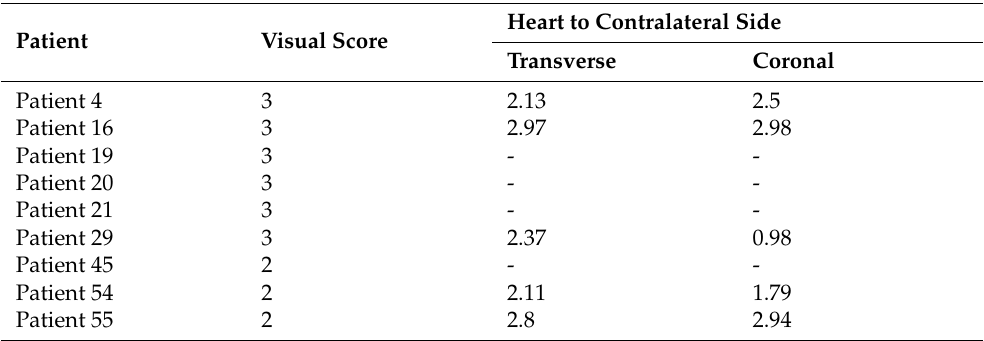
Table 3. Semiquantitative Method, results for ATTR positive patients on SPECT centered-on-the- thorax